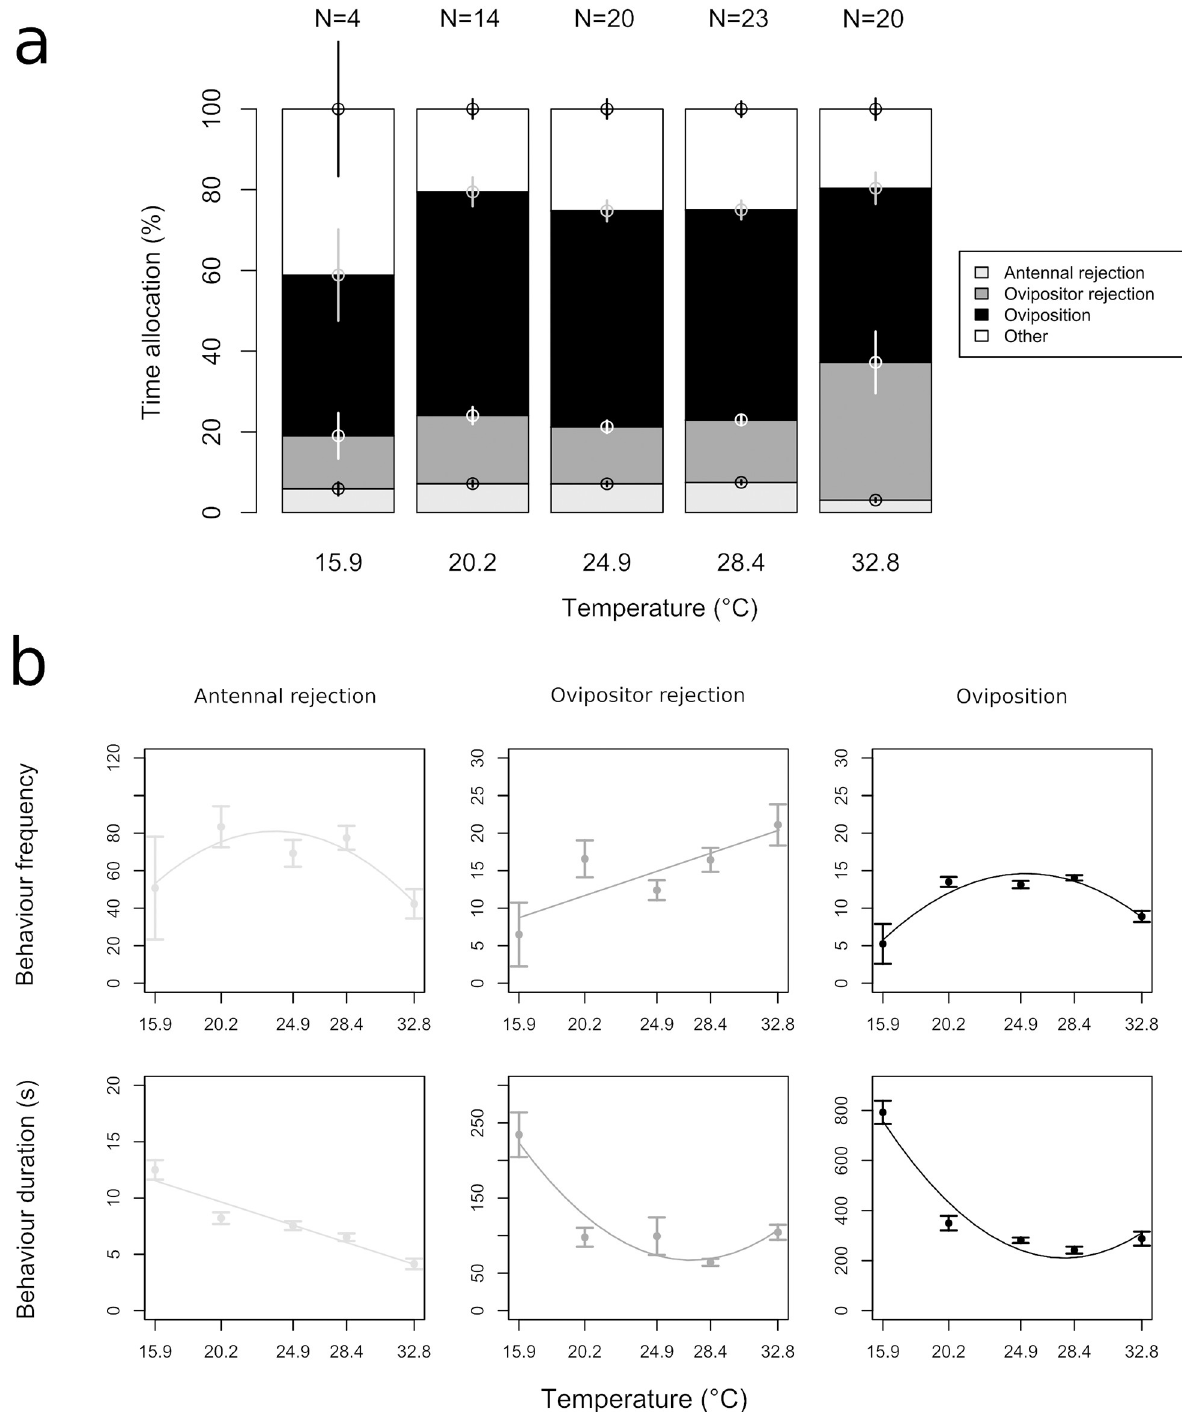
Fig 2. (a) Time allocation of behaviours of Anaphes listronoti females during host patch exploitation ( Listronotus oregonensis ) as related to temperature. Other behaviours include grooming, resting and walking. ( � X � SE ) (b) Frequency and duration of A . listronoti females’ behaviours at different